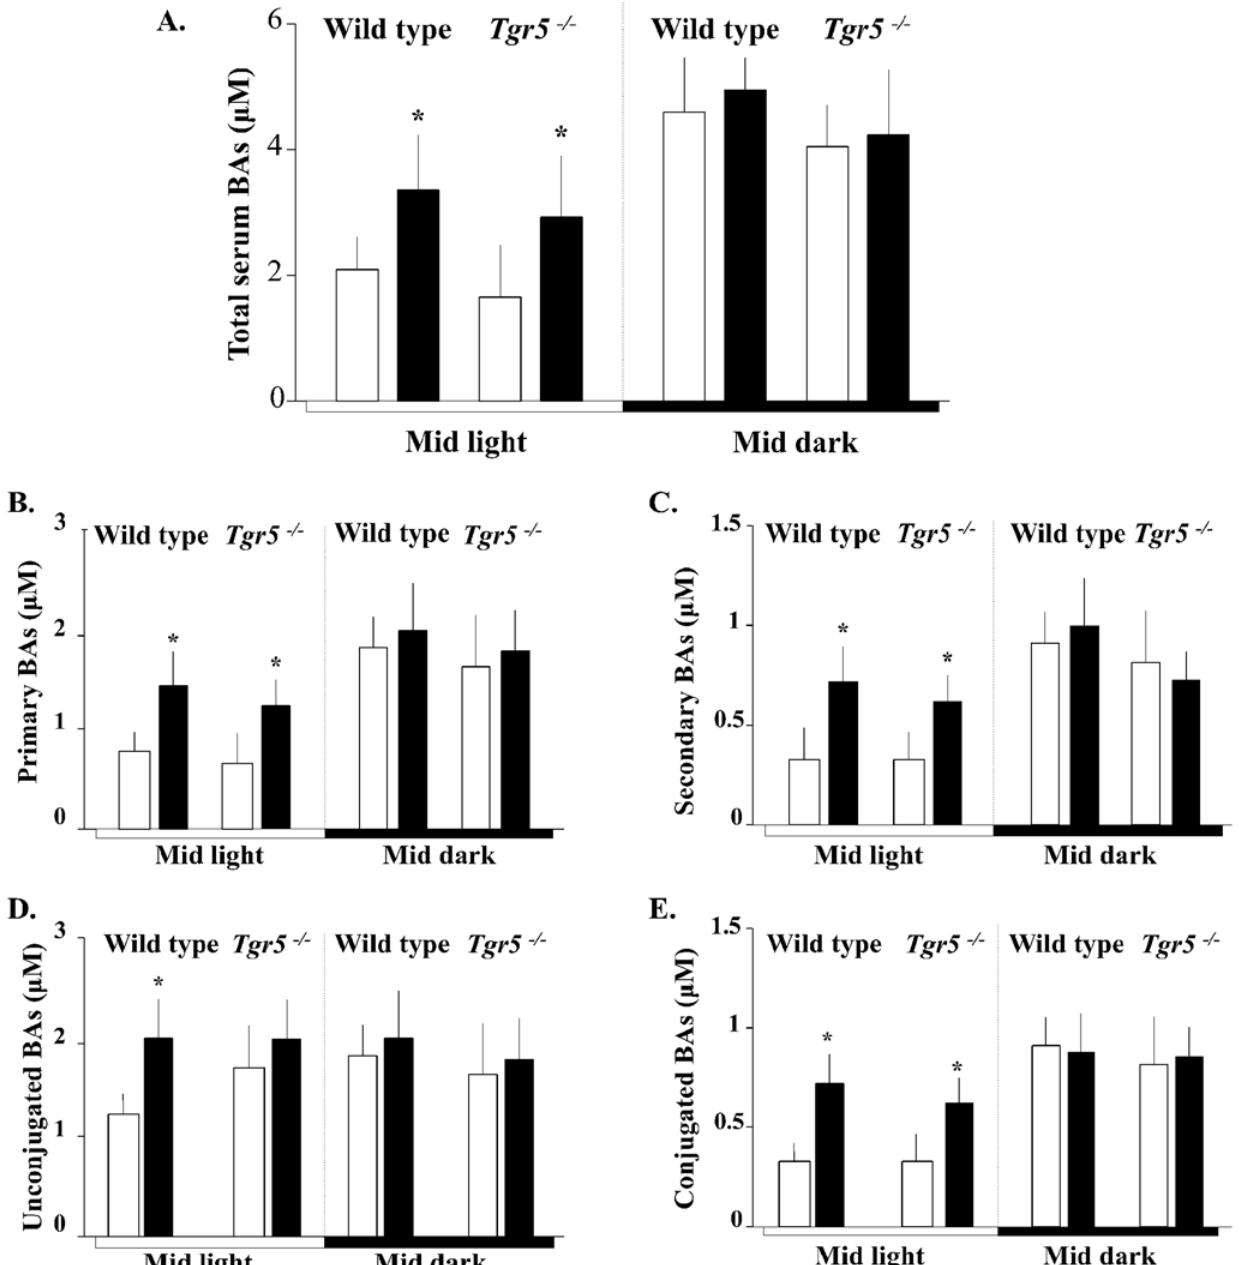
Fig 3. Effect of XGB on serum BAs concentration in wild-type and Tgr5 -/- mice fed a chow diet. Blood specimens were obtained at the middle of the light and dark phases of the diurnal cycle to 5 – 6 wild — type and 4 – 5 Tgr5 -/- mice in each group of animals. White bars represent sham — operated mice and black bars represent mice subjected to XGB. Panel A shows total serum BAs concentration. Primary and secondary serum BAs concentrations are shown in panels B and C, respectively. Conjugated and unconjugated serum BAs levels are shown in panels D and E, respectively. Values represent the mean ± S.E. M. * p <